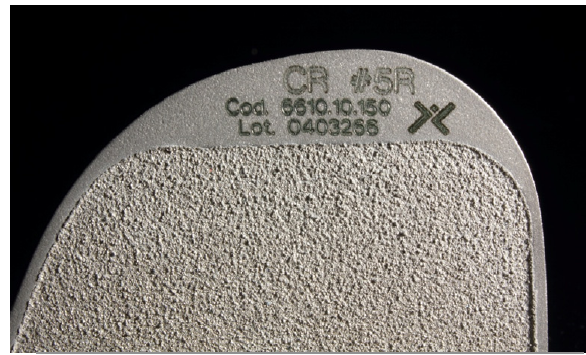
Figura 2: Finitura superficiale interna in titanio poroso della componente femorale. Figure 2: Porous titanium surface roughness of the femoral